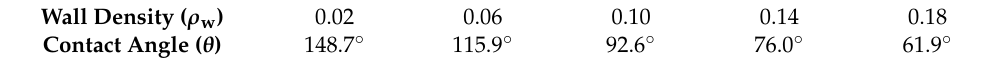
Figure 7. Fluids in a rock micro-fracture with different contact angles: ( a ) θ = 148.7°; ( b ) θ = 92.6°; ( c ) θ = 61.9°.